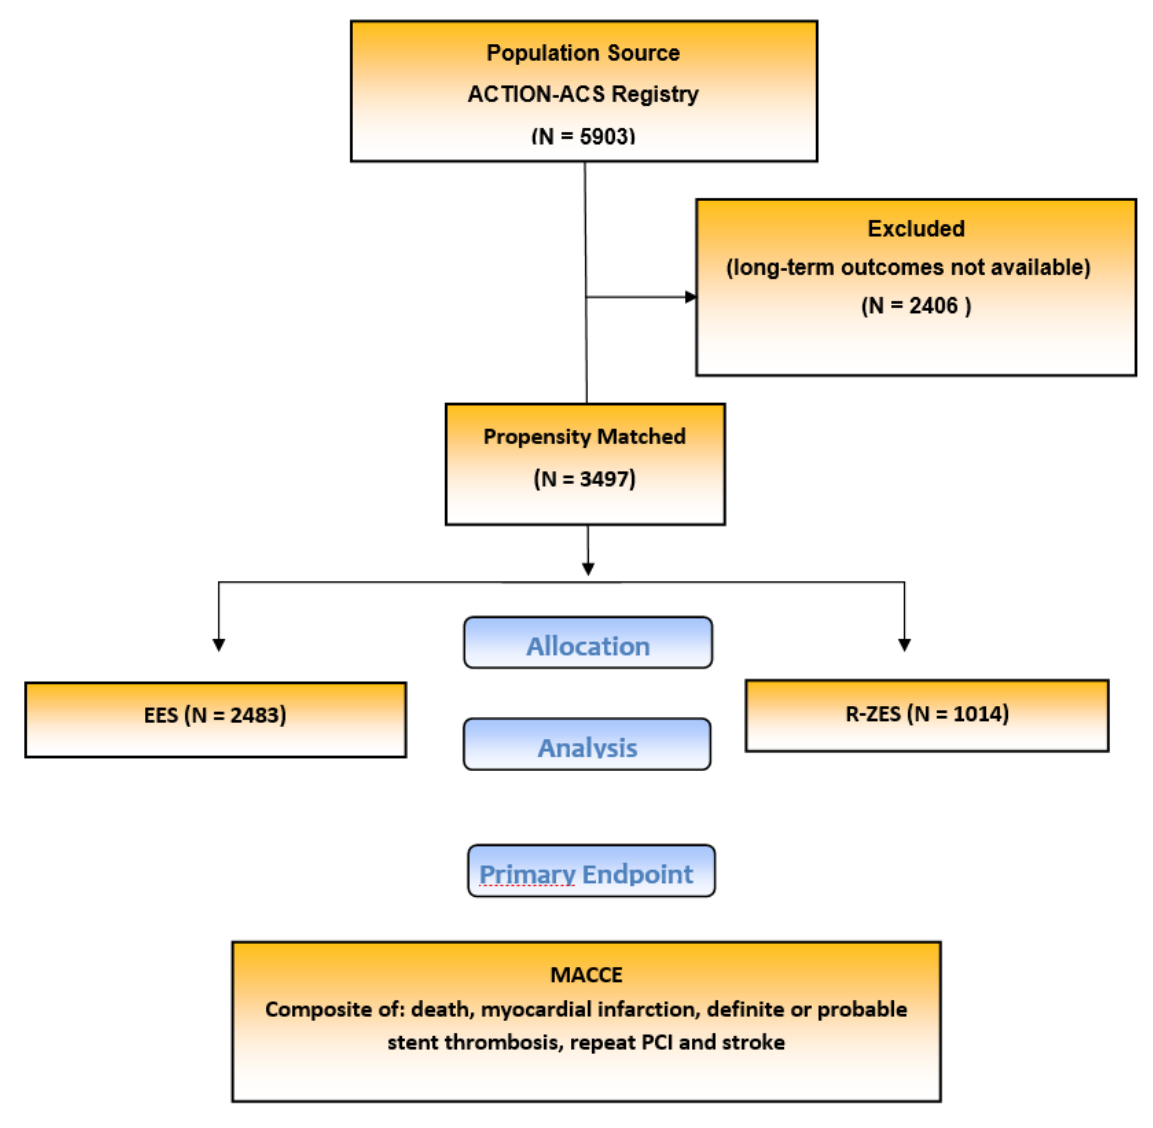
Figure 1. Study flow chart. EES, everolimus-eluting stent; R-ZES, resolute zotarolimus-eluting stent; MACCE, major adverse cardiovascular and cerebrovascular events; PCI, percutaneous coronary intervention.